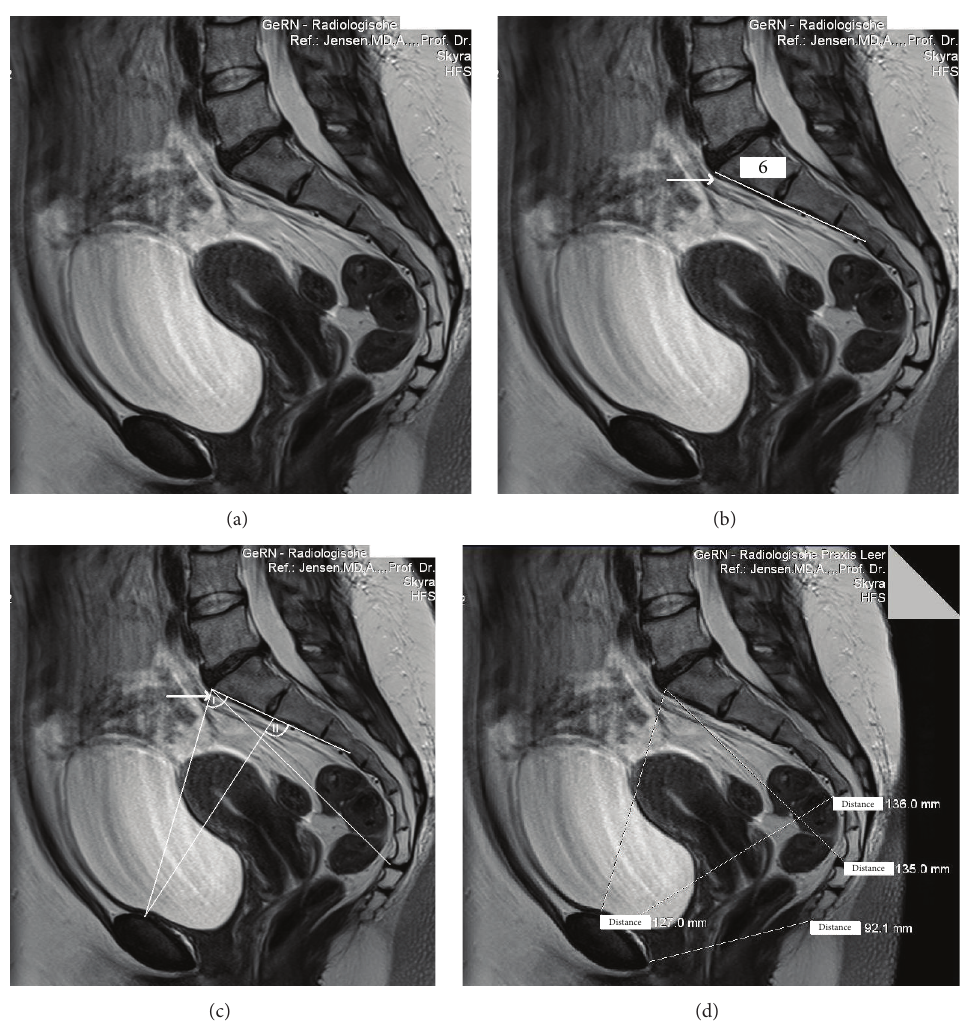
Figure 1: MRI of the maternal pelvis (I.H.). (a) This MRI documents a “long pelvis” [2] with assimilated (fused) lumbar vertebral body to form a sacral bone with an excessive vertebral body (arrow). (b) The “long pelvis” has 6 vertebral bones instead of the normal 5. In addition, the 6 sacral bones in the “long pelvis” fail to be concave; rather they form a straight plane (indicated by the straight line), which reduces the capacity of the mid-pelvis. (c) The pelvic inlet angle is < 90 ∘ (angle I) in a “long pelvis” [2]. (d) The distance from the top of the 6th (excessive) vertebral body to the end of the sacral bone in this “long pelvis” [2] is prolonged ((d), distance 135 mm) (3-Tesla, T1w TSE triplanar